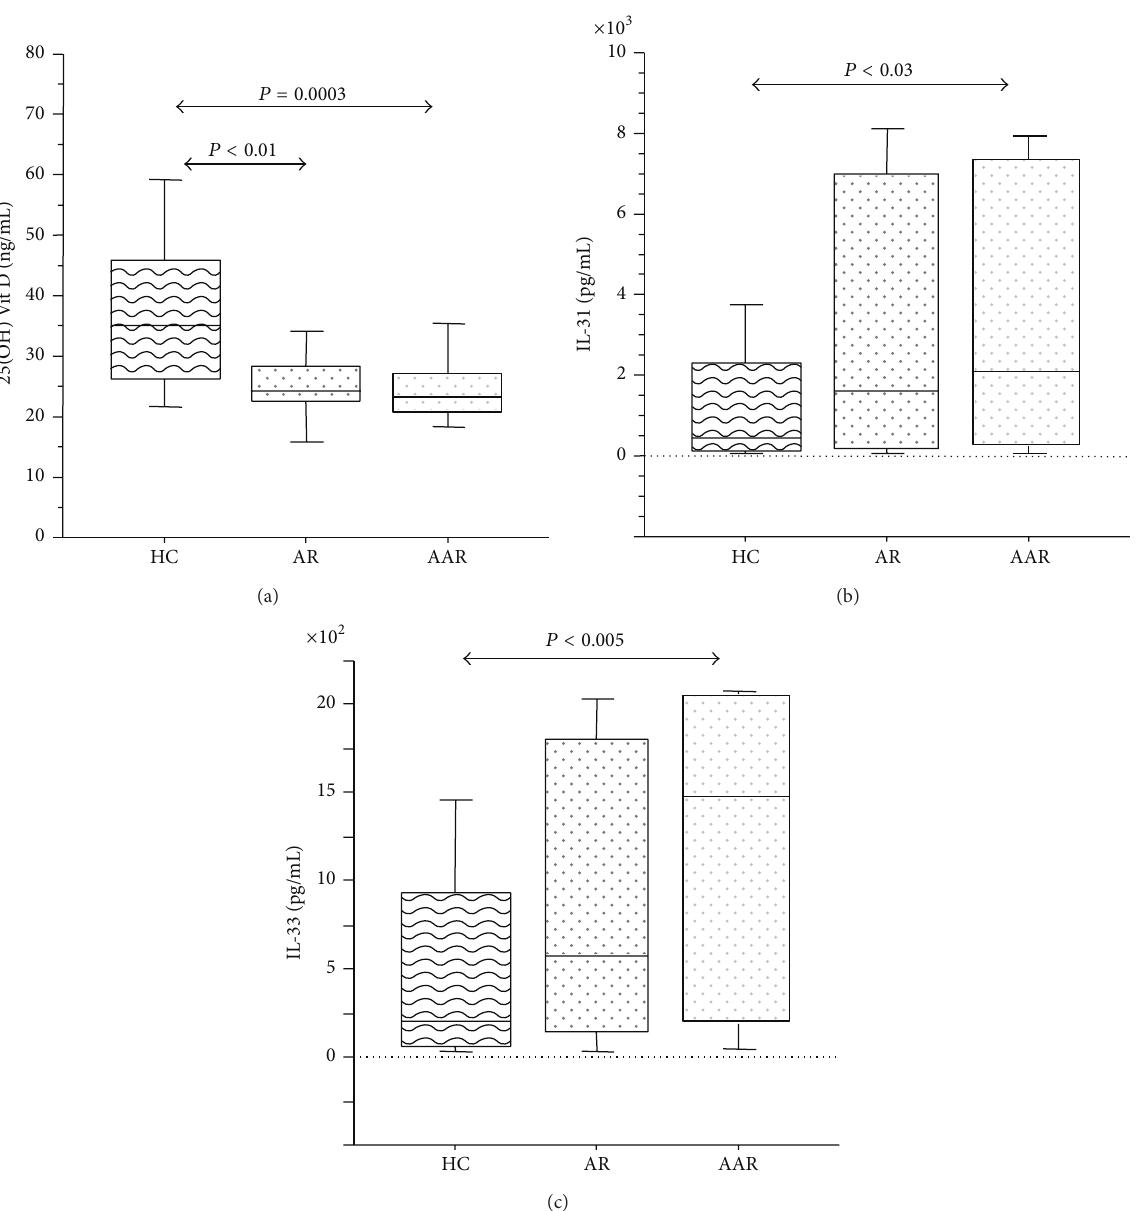
Figure 1: Plasma levels of 25(OH) Vit D (ng/mL), IL-31 (pg/mL), and IL-33 (pg/mL) in HC ( 𝑛 = 28 ) compared to patients with AR ( 𝑛 = 11 ) and patients with AAR ( 𝑛 = 35 ). 25(OH) Vit D concentrations (a), IL-31 concentrations (b), and IL-33 concentrations (c) were analyzed by specific ELISA. Bars in the box plots indicate (from the bottom to the top) 10th, 25th, 50th (median), 75th, and 90th percentiles. Statistical analysis was performed by Kruskal-Wallis test and Mann-Whitney U test. Significance was accepted at 𝑃 < 0.05 .